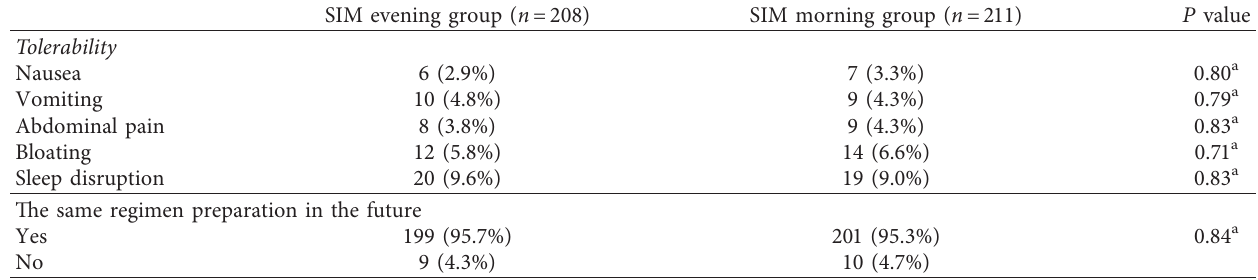
Table 4: Patients’ compliance and